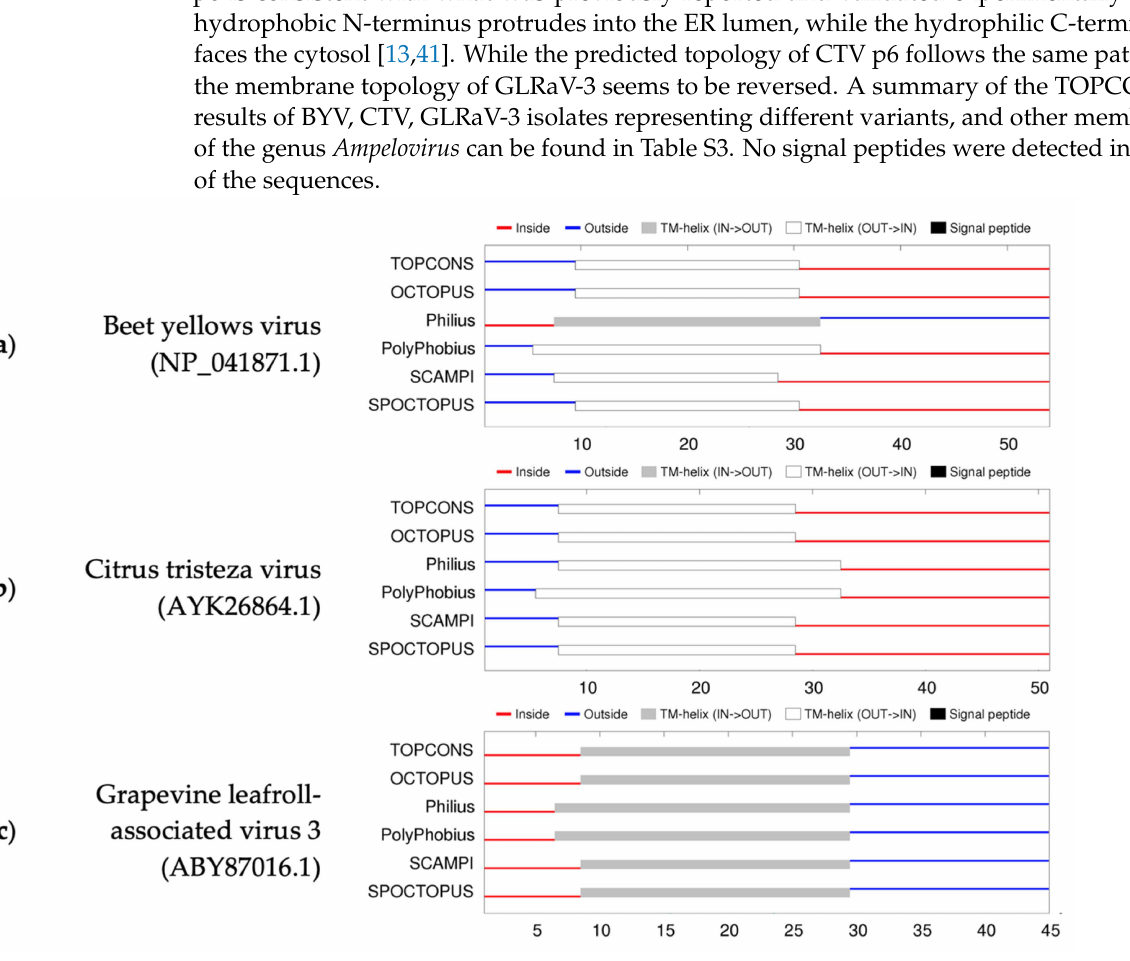
Figure 3. A visual summary of the membrane topology predictions of ( a ) beet yellows virus (BYV) p6, ( b ) citrus tristeza virus (CTV) p6, and ( c ) grapevine leafroll-associated virus 3 (GLRaV-3) p5 using six different algorithms in TOPCONS [39]. Amino acid positions are indicated below each figure. Blue lines represent amino acids predicted to reside on the outside lumen of ER; while red lines indicate amino acids predicted to be localised inside the cytosol. Areas predicted as transmembrane helices (TM) are illustrated in grey or white. No signal peptides were